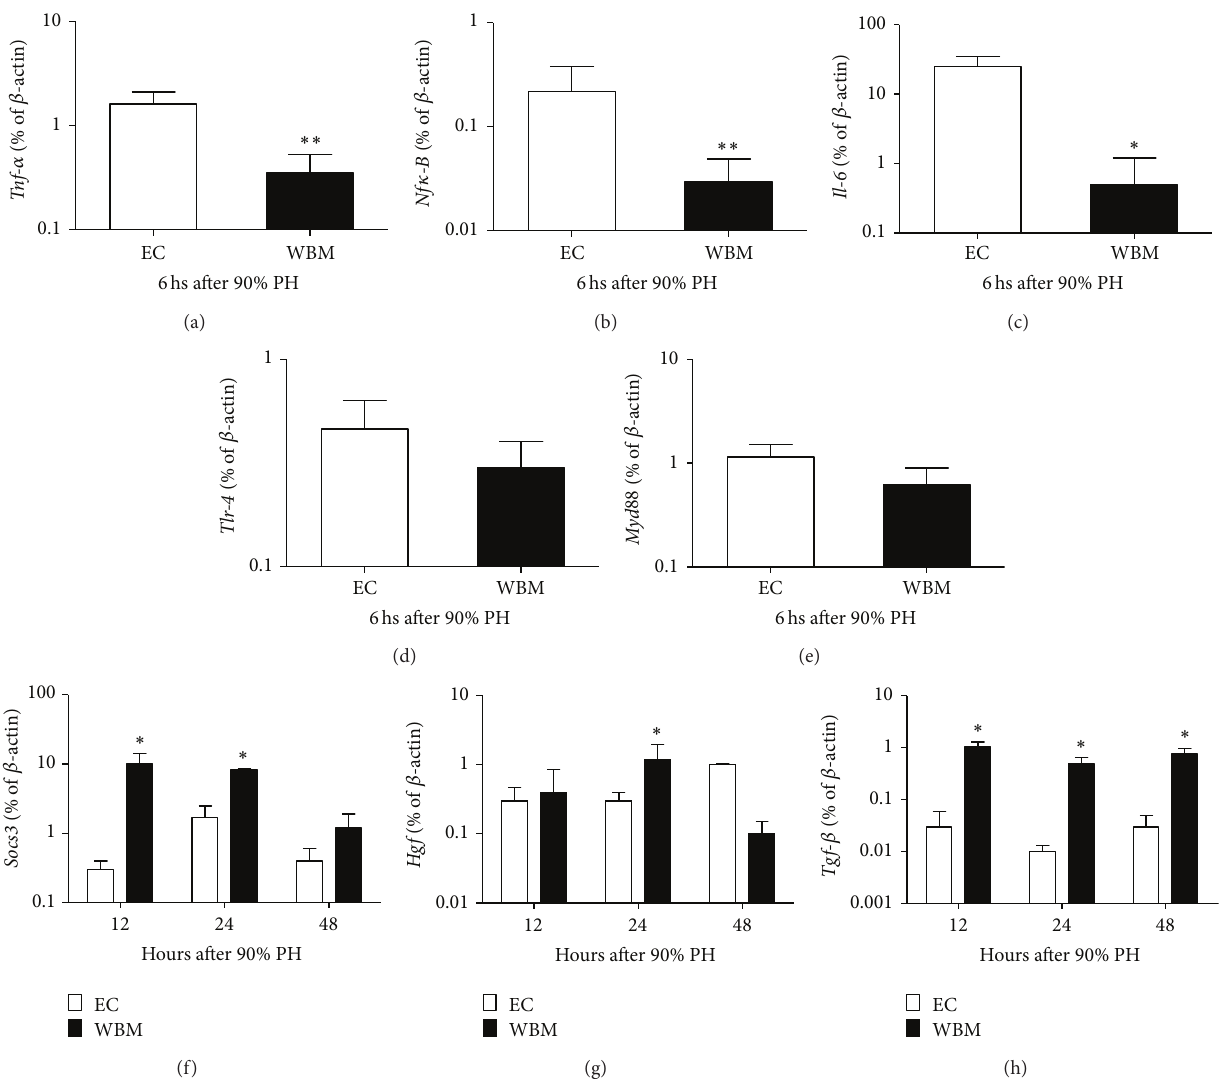
Figure 2: Liver gene expression after 90% partial hepatectomy (PH). Liver gene expression of Tnf- 𝛼 (a), Nf 𝜅 -B (b), Il-6 (c), Tlr-4 (d), and Myd88 (e) 6 hours after 90% partial hepatectomy and Socs3 (f), Hgf (g), and Tgf- 𝛽 (h) 12, 24, and 48 hours after 90% partial hepatectomy. WBM: whole bone marrow; EC: empty capsules. Values are expressed as means ± SD in log scale. Student’s 𝑡 -test, ∗ 𝑃 < .05 , ∗∗ 𝑃 < .01